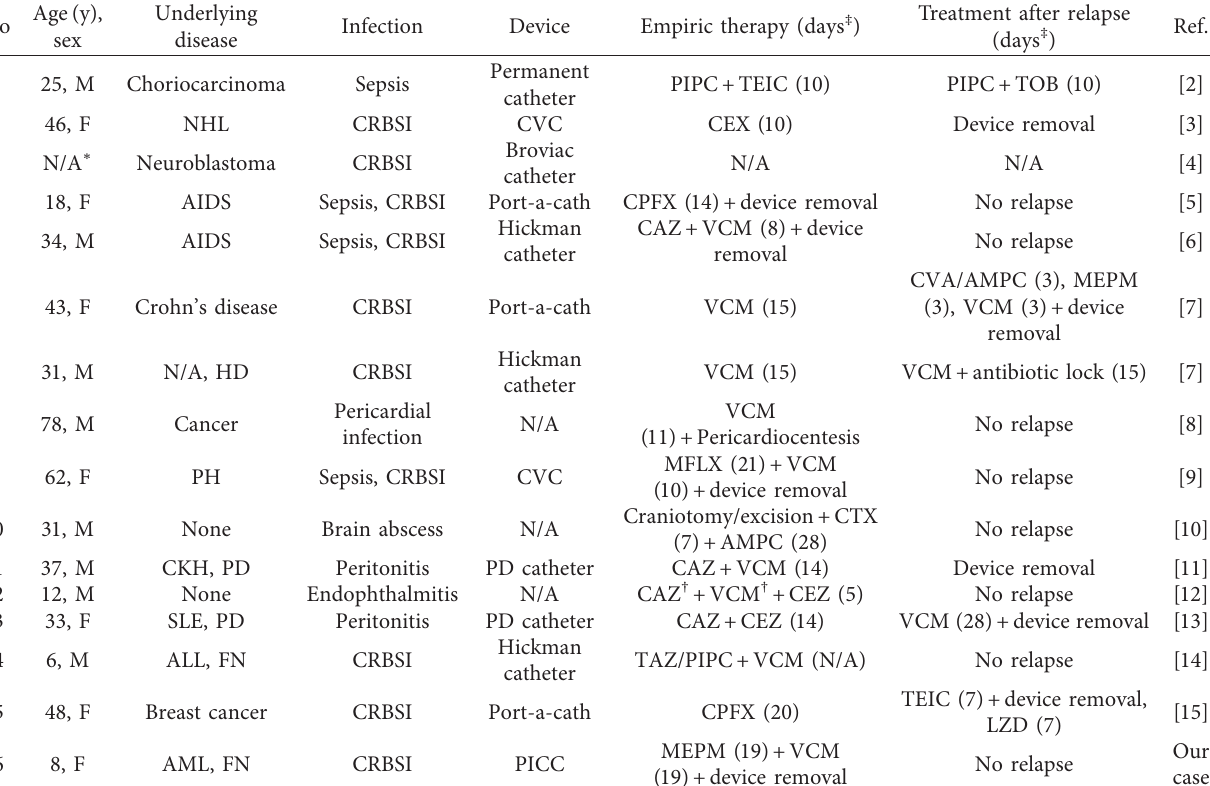
Table 1: Characteristics, treatment, and outcomes of the Brevibacterium casei infection cases identified in a PubMed search conducted